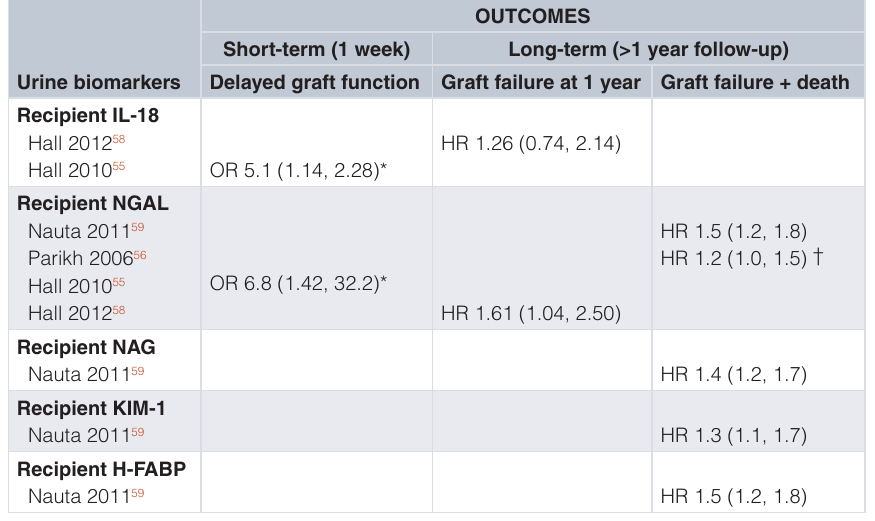
Table 4. Biomarkers of AKI and outcomes in kidney